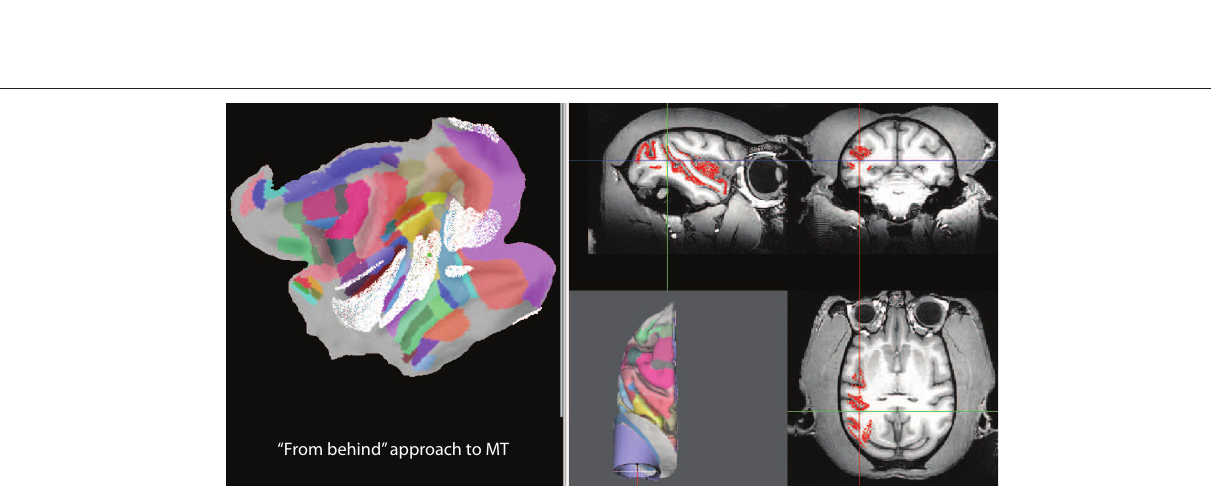
Figure 6 | Visualization of all parts of the brain that can be accessed with an alternative “straight down” approach (elevation and tilt of zero).